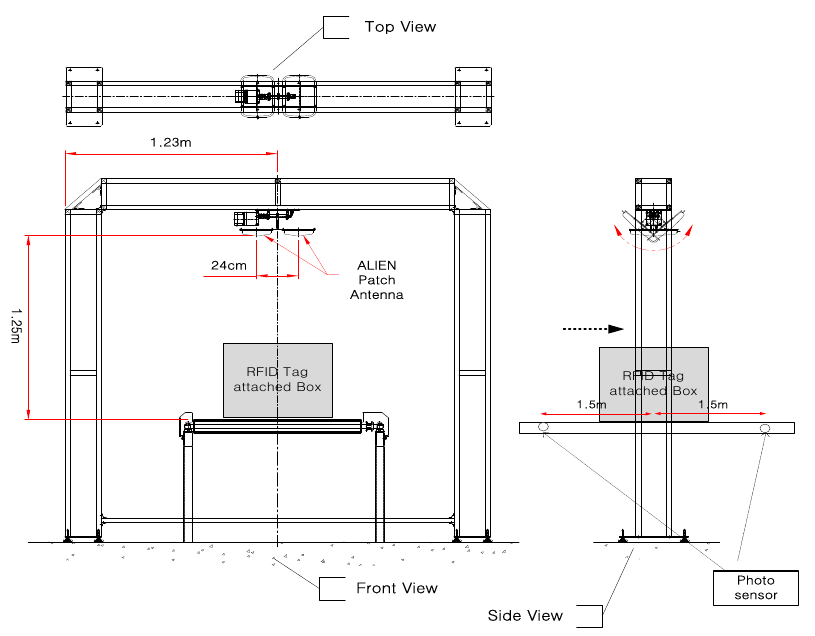
Figure 6. An experimental structure.